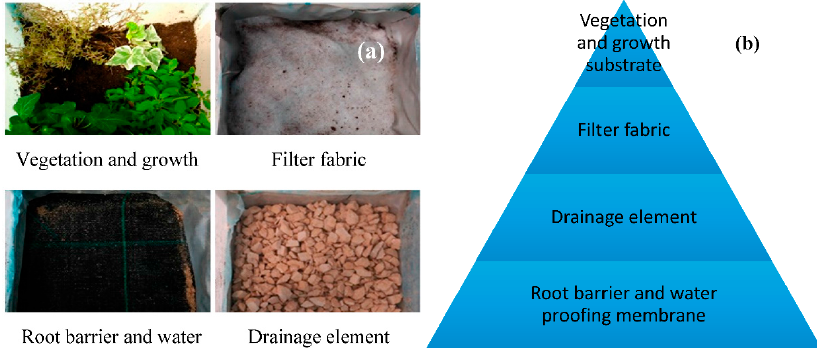
Figure 1. ( a ) Layers used in a Conventional Green Roofs; ( b ) Green Roof Scheme.